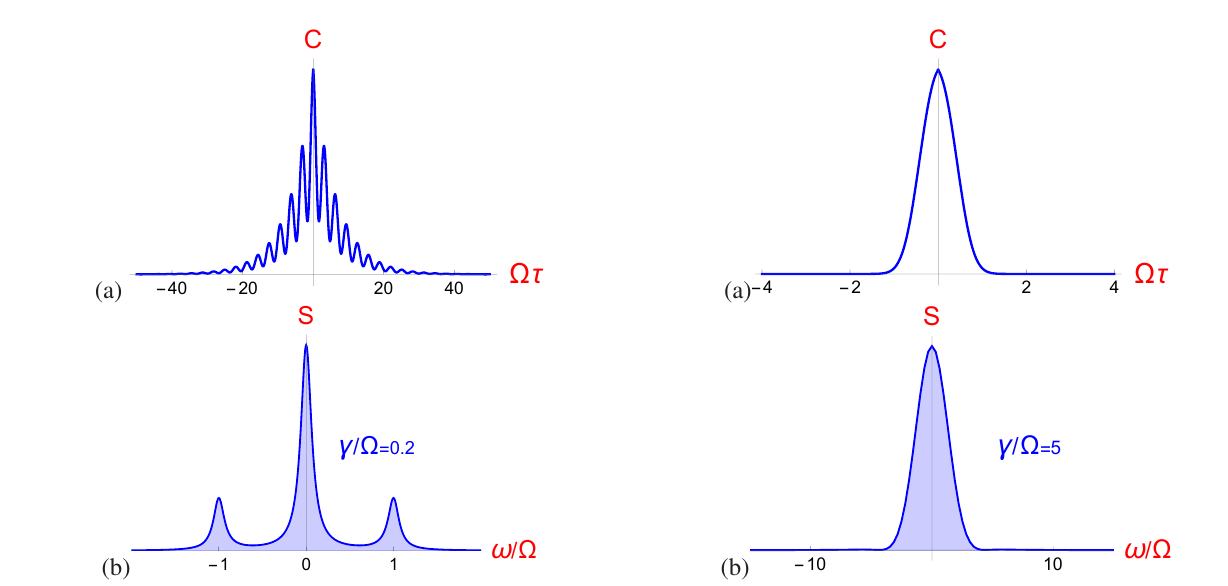
Fig. 3. (a) Scaled correlation functions versus ⌦ ⌧ without the rapid phase, defined by Eq.(48). (b) Fourier transform of c ( ⌦ ⌧ ), or spectrum versus the shifted frequency ! ing, γ/ ⌦ = 0 . 2 .